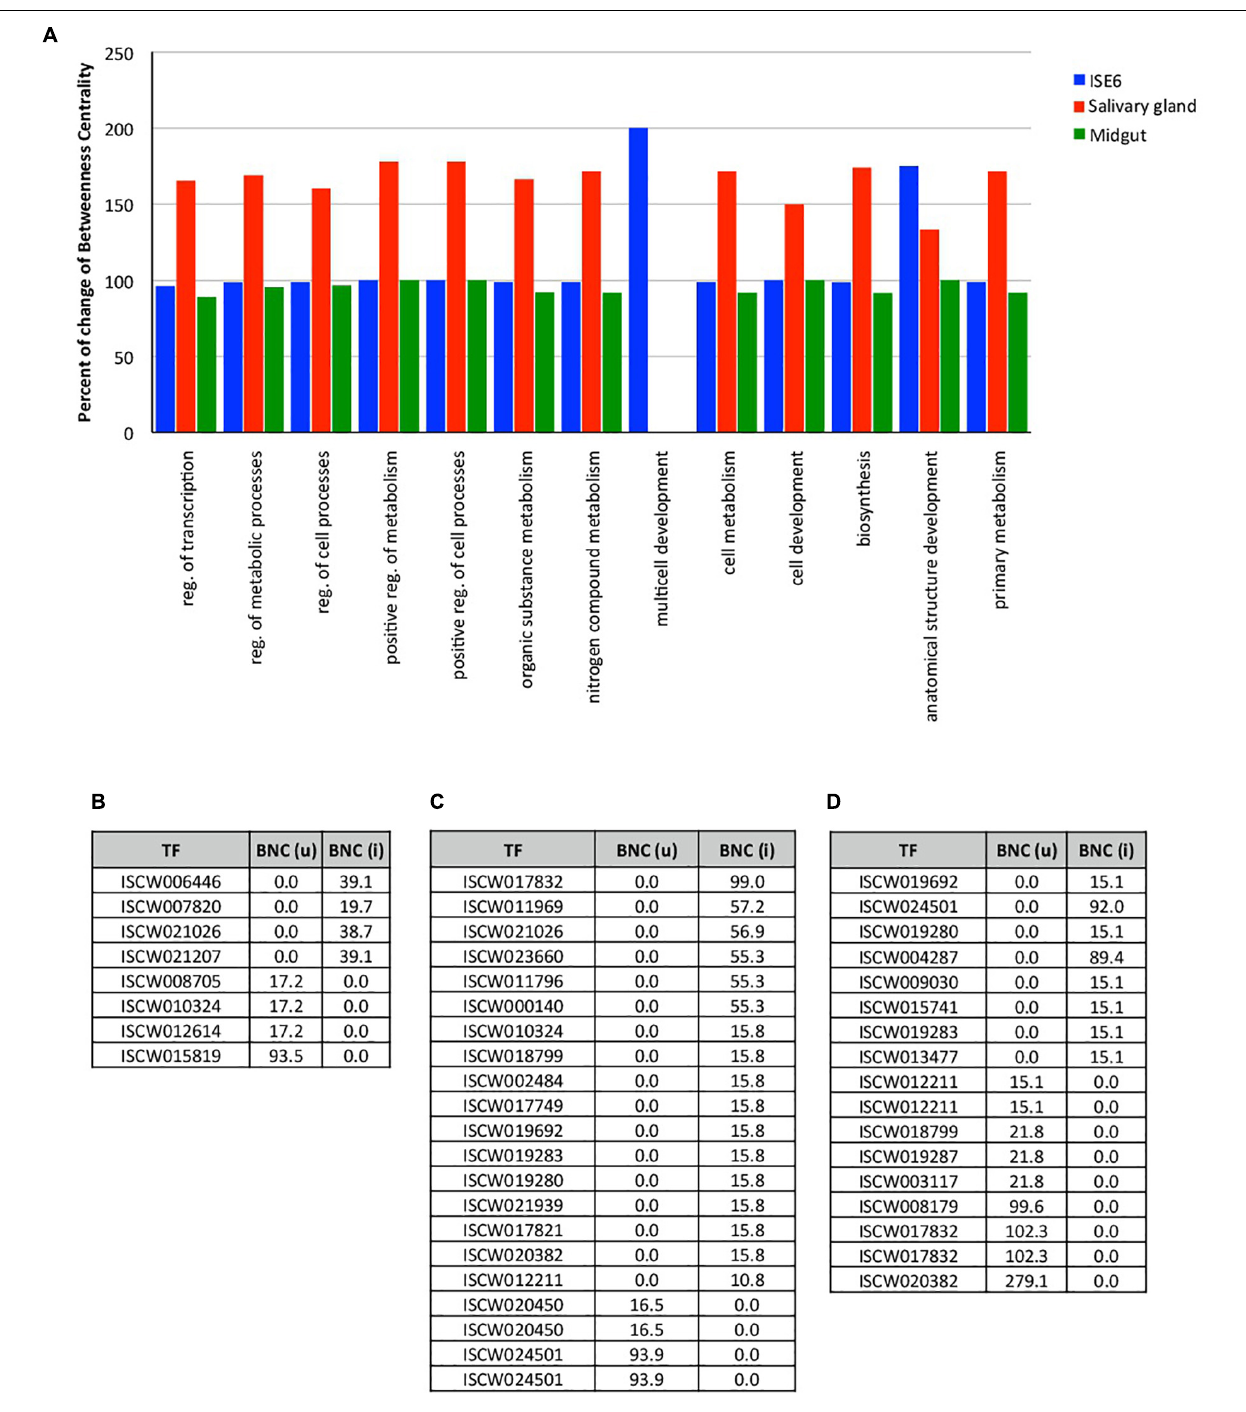
Frontiers in Physiology |